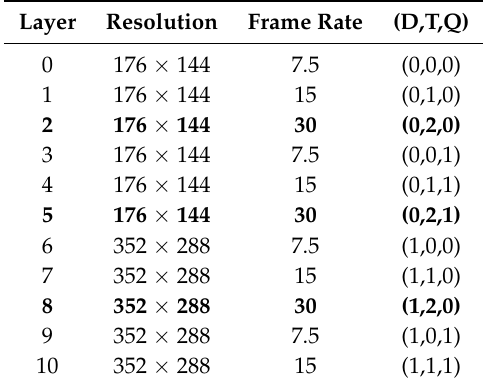
Table 3. Encoder output for a general encoding scheme for the crew video, composed of two resolutions, two quality levels and three frame rates.